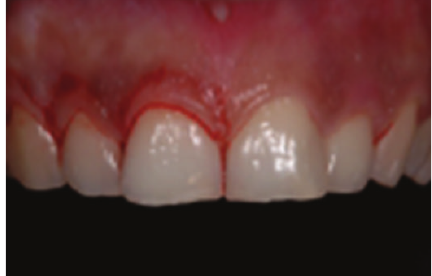
Figure 8: Flap design adapted to the hidden anatomy.